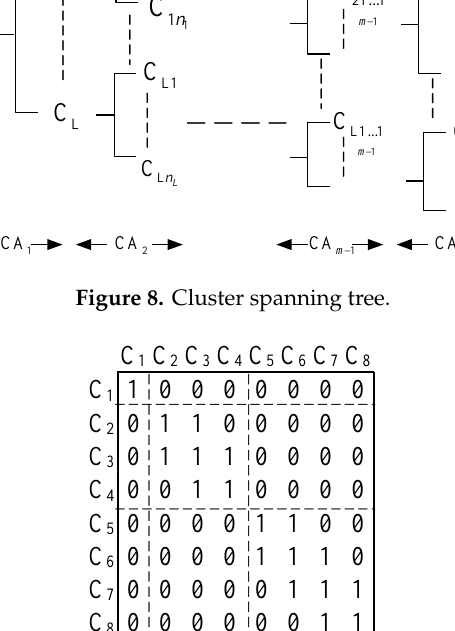
Figure 8. Cluster spanning tree.